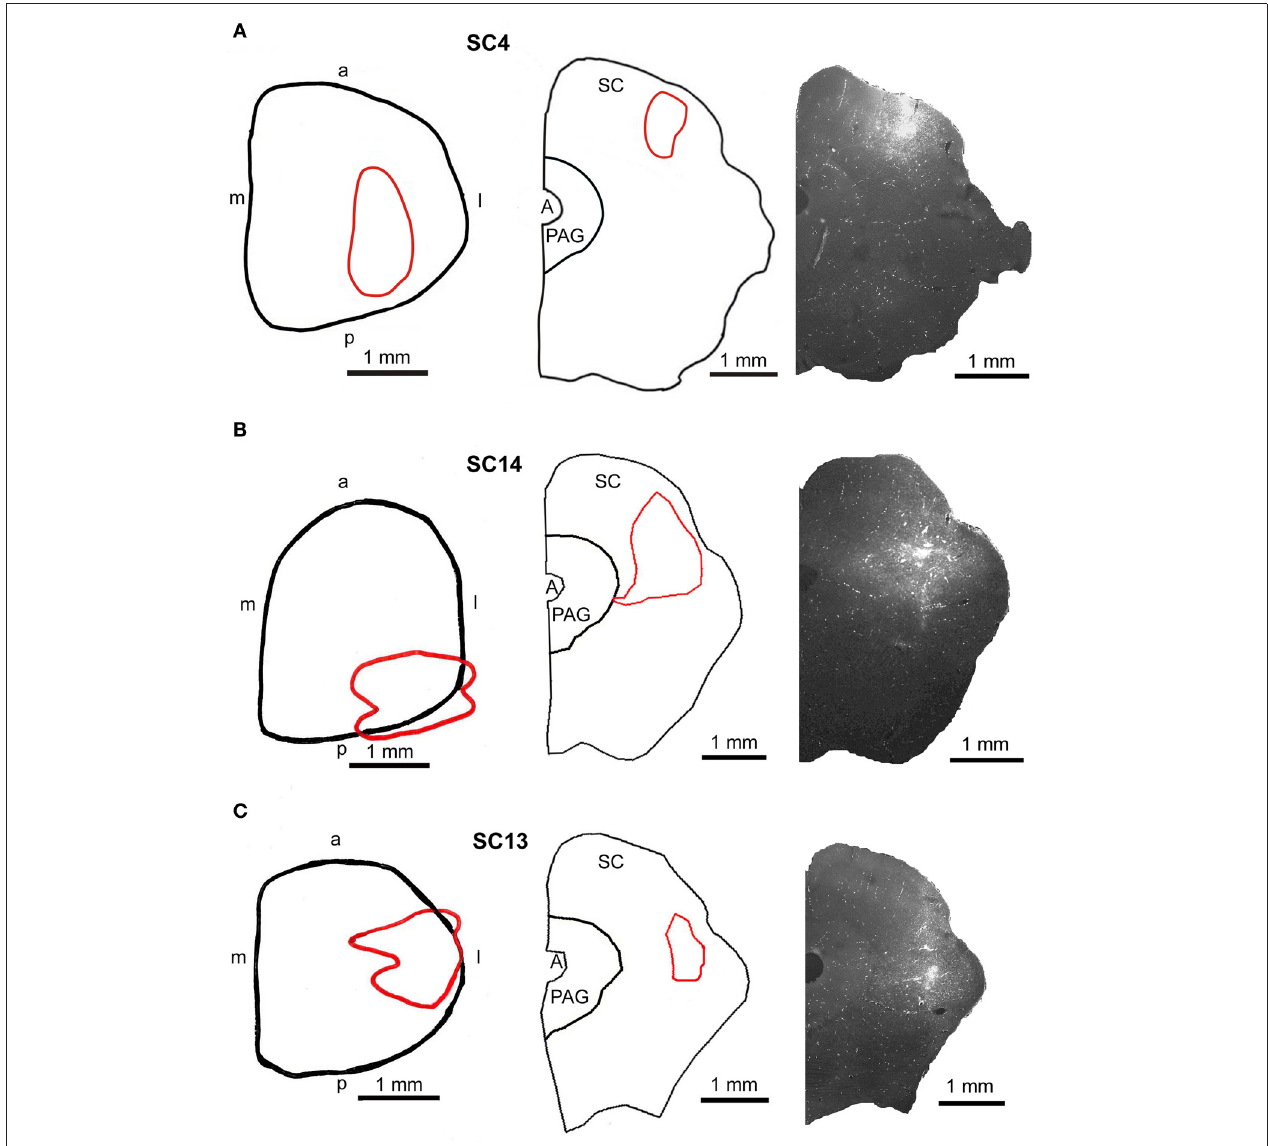
FIGURE 7 | Injection sites into the superficial (A, SC4), the intermediate-deep (B, SC14), and the deep (C, SC13) layers of the superior colliculus. Left panel: reconstructions of the dorsal view of the right SC, middle panel: drawings of frontal sections through the center of the